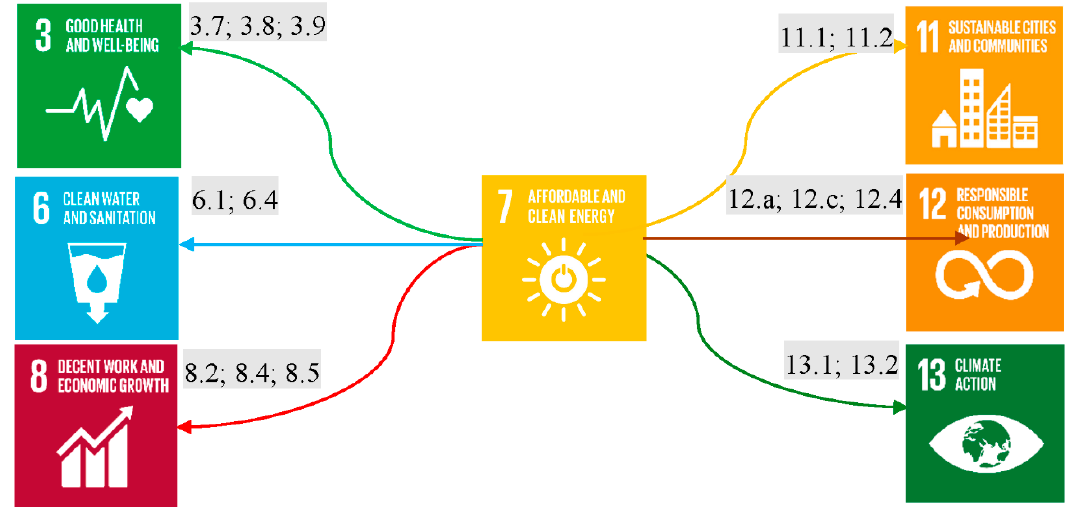
Figure 7. The relationship and interlinked of targets between SDG 7 with SDG 3, 6, 8, 11, 12, and 13 (Yong Zi Jun, 2019).